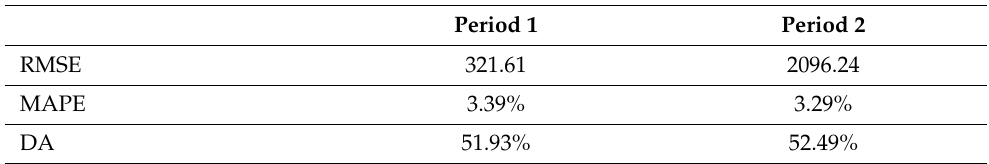
Table 4. Error results for random forest